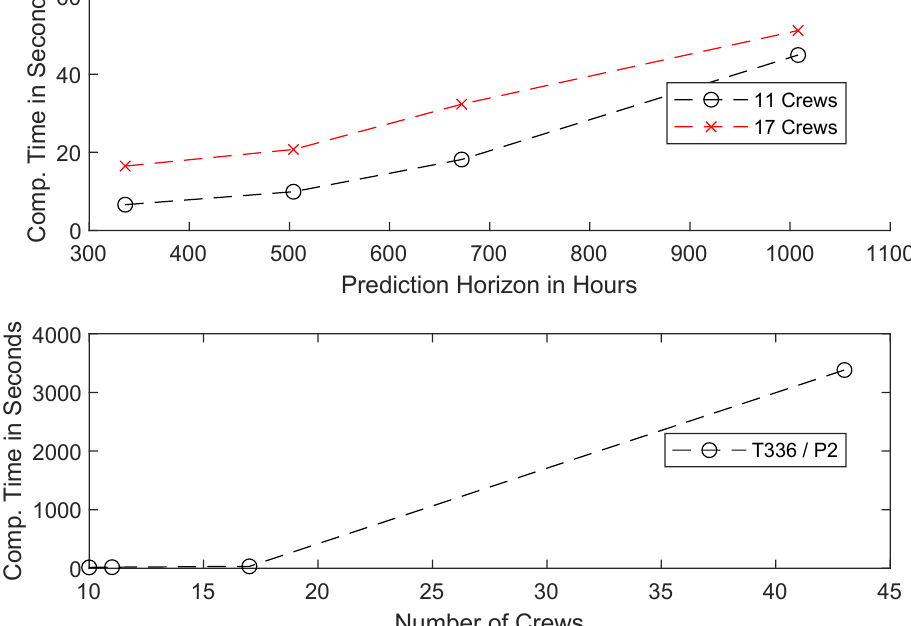
Figure 7. Computational time depending on the planning horizon ( top ) and the number of personnel ( bottom